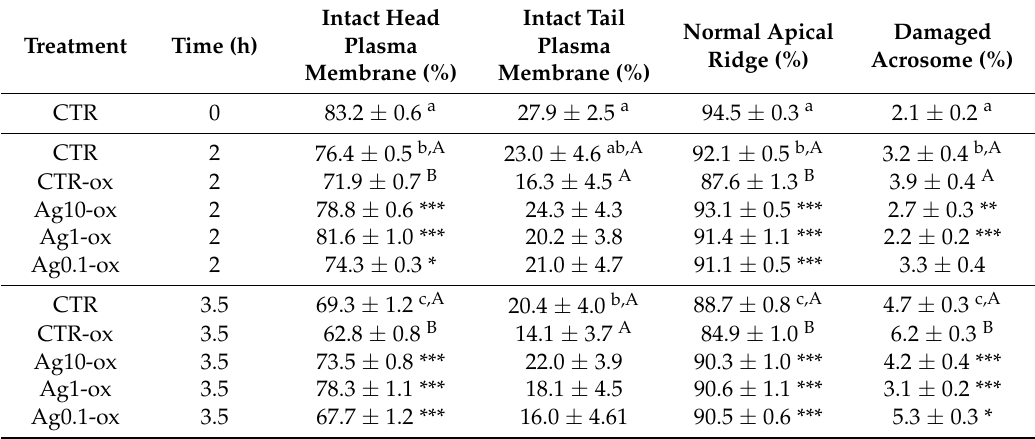
Table 3. Boar sperm plasma membrane integrity and acrosomal status in samples submitted to oxidative stress (CTR except) and supplemented with